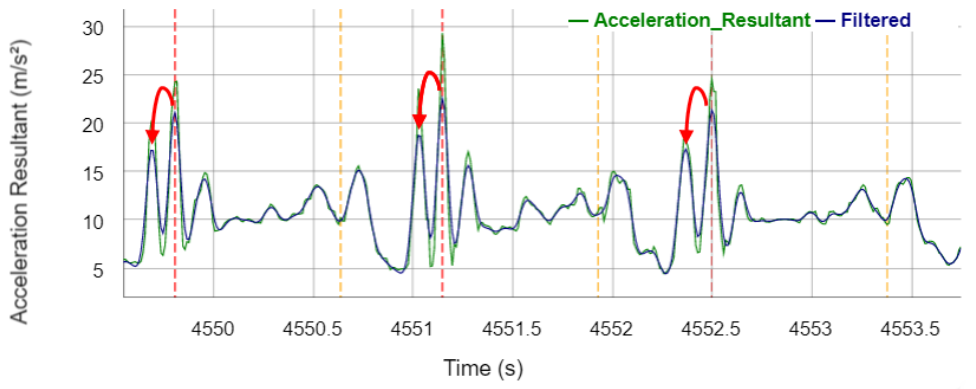
Figure 9. Acceleration resultant signal of the IMU during three stem phases. Vertical dashed lines visualize the events detected by the algorithm (Vertical dotted lines legend: red: IC IMU ; orange: TO IMU ). Red arrows illustrate the optimization